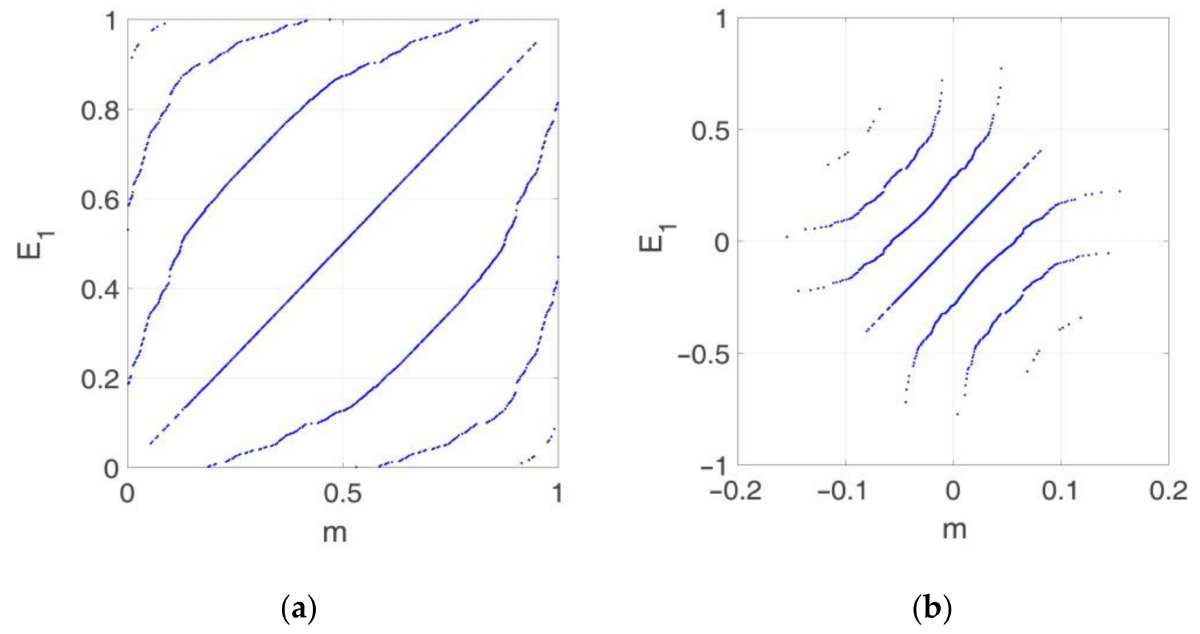
Figure 4. ( a ) Division of the CDFs equally and pairing process; ( b ) resulting sample points. Table 3. Statistical data of the estimated EI 2 and EI 3 under different measurement sets (normalized). EI 2 EI